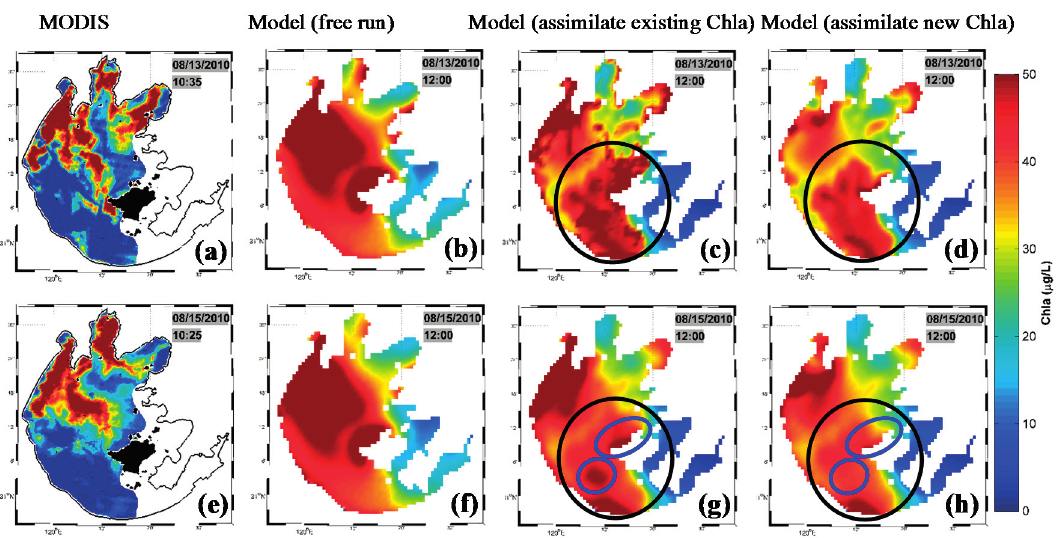
Figure 8. Top panels in ( a – d ): Chla distributions on 13 August 2010. (a) MODIS (EOF algorithm); (b) Forecast model (EcoTaihu, started from 1 August) without assimilating MODIS data; (c) Forecast model after assimilating MODIS Chla from the existing BP algorithm [42]; (d) Forecast model after assimilating MODIS Chla from the new EOF algorithm (a). The forecast model (EcoTaihu) generated model output every 24 h on 12:00 AM local time. Bottom panels in ( e – h ): Chla distributions on 15 August 2010. Note